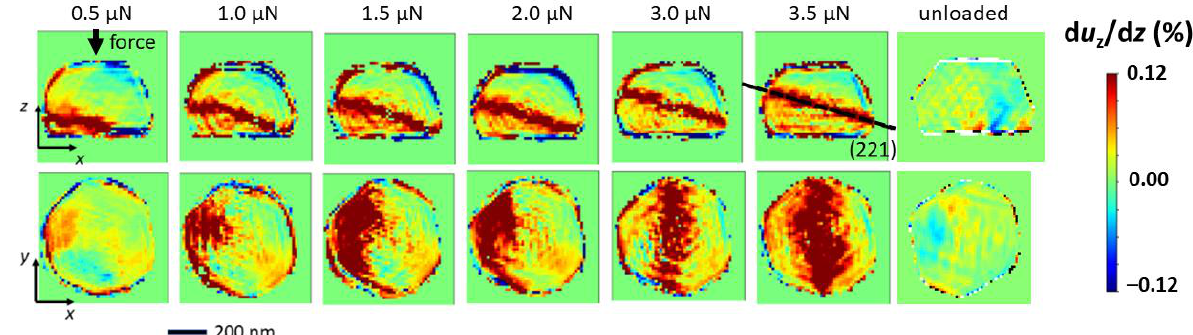
Figure 4. Reconstructed out-of-plane strain field in the Au crystal during nano-indentation recon- structed from the BCDPs presented in Figure 2. X , Y , and Z axis correspond to the [ 112 ̅] , [ 1 ̅ 10 ] , and [ 111 ] crystallographic directions, respectively.